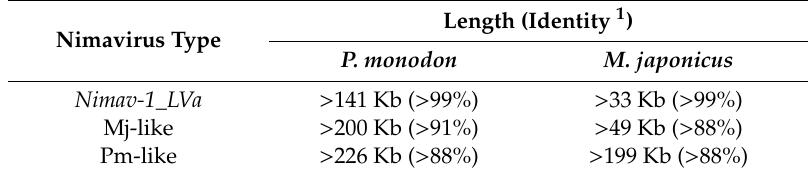
Table 2. Three types of nimavirus sequences were detected in two shrimp